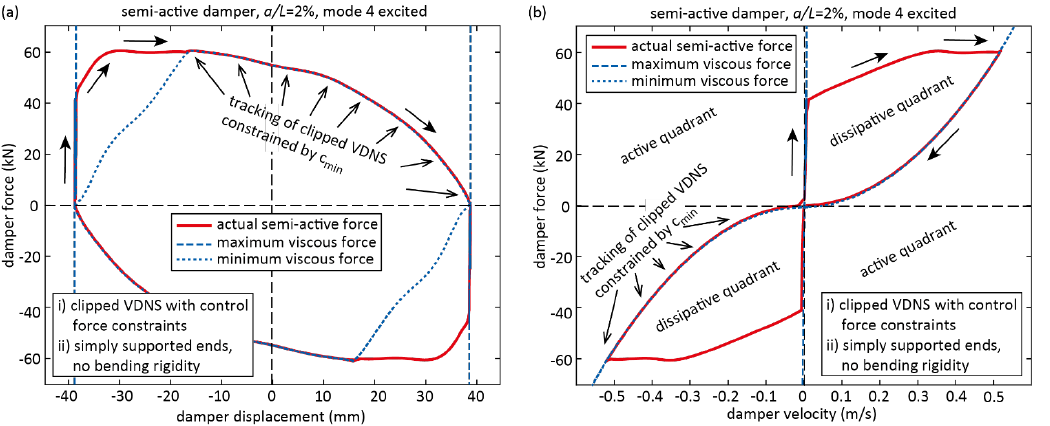
Figure 9. Simulated clipped VDNS with control force constraints for mode 4: ( a ) force displacement curves and ( b ) force velocity curves during steady state conditions (before simulated free decay response).